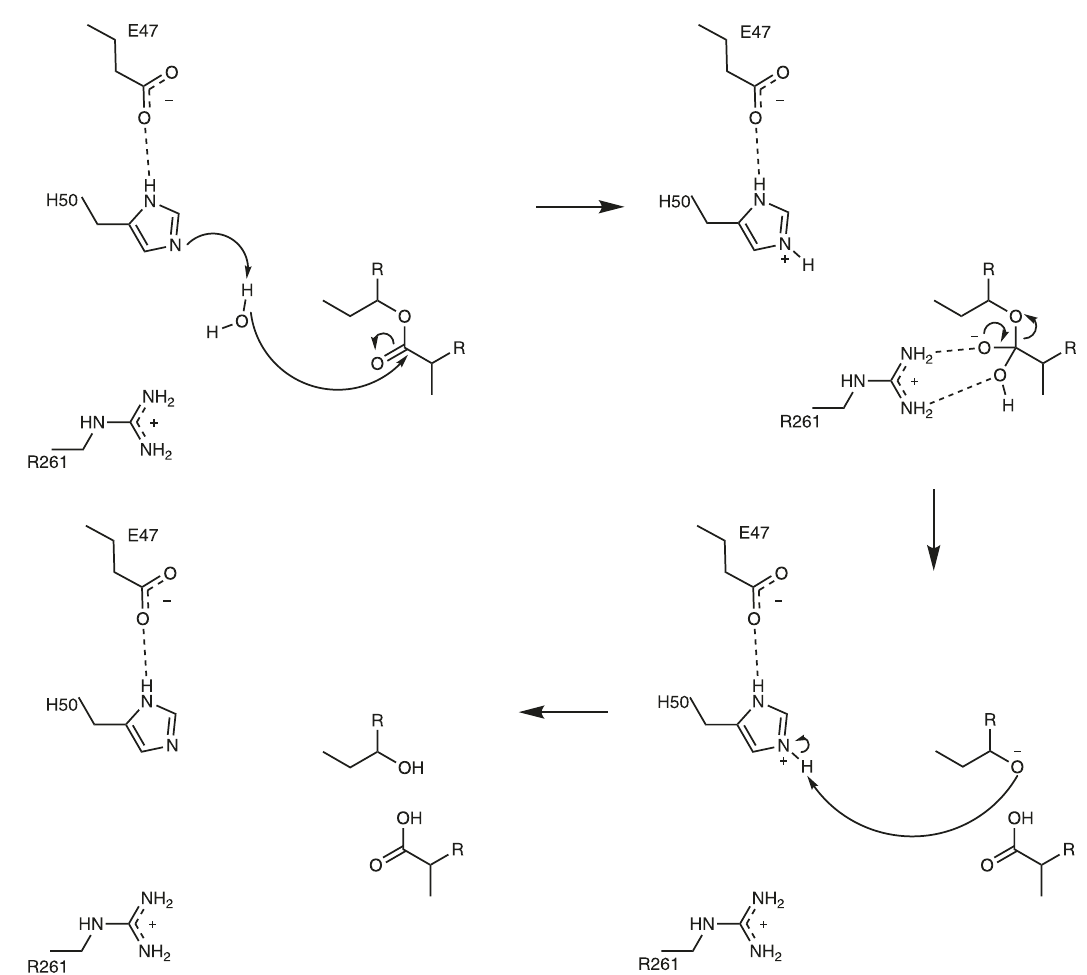
Fig. 5 Catalytic mechanism of EreC. Proposed enzymatic reaction mechanism employed by EreC, displaying a cropped molecule of erythromycin and amino acids directly implied in